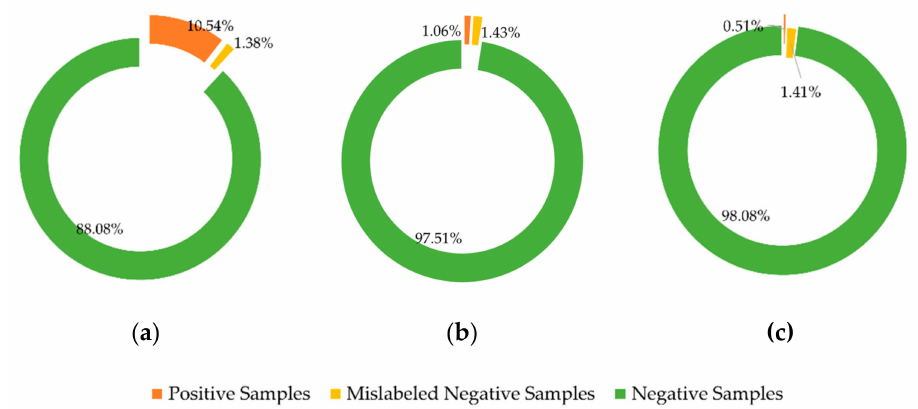
Figure 6. The proportion of positive samples, mislabeled negative samples, and the rest of the negative samples for the ( a ) SIXray10, ( b ) SIXray100, and ( c ) SIXray1000